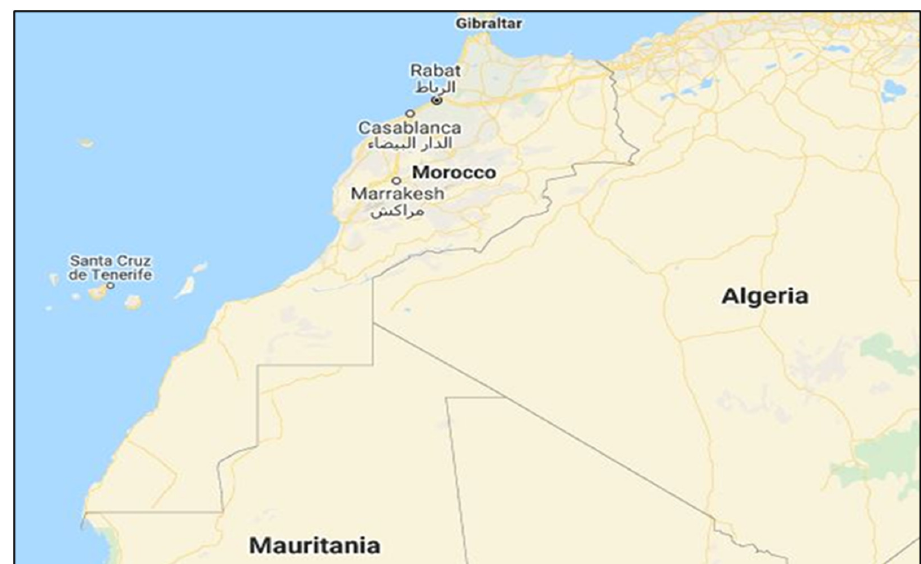
Figure 1. Map of Morocco